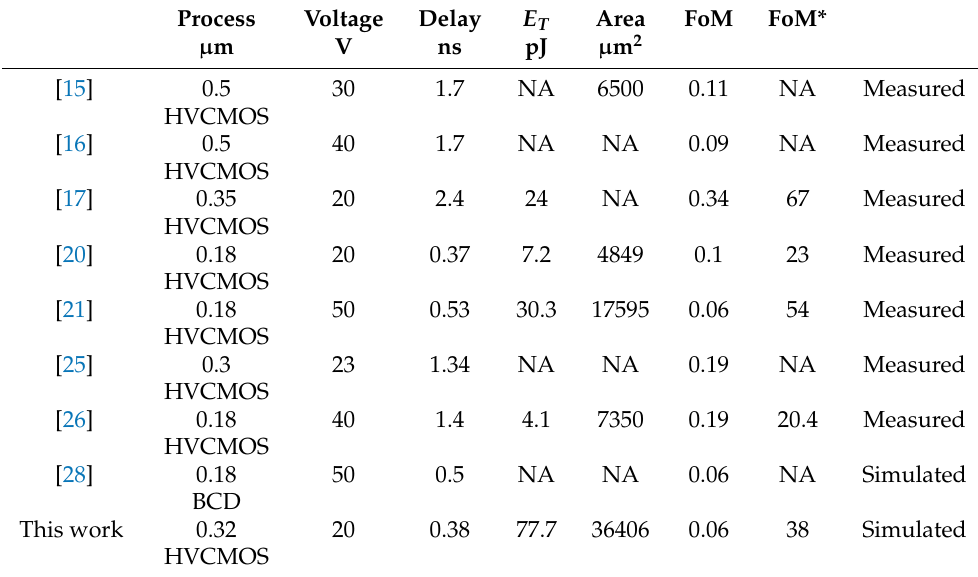
FoM from [16]: (Delay)/(Process · Voltage). Unit: ns/( µ m · V); FoM* from [20]: ( E T · Delay)/(Process 3 · Voltage). Unit: (pJ · ns)/( µ m 3 ·